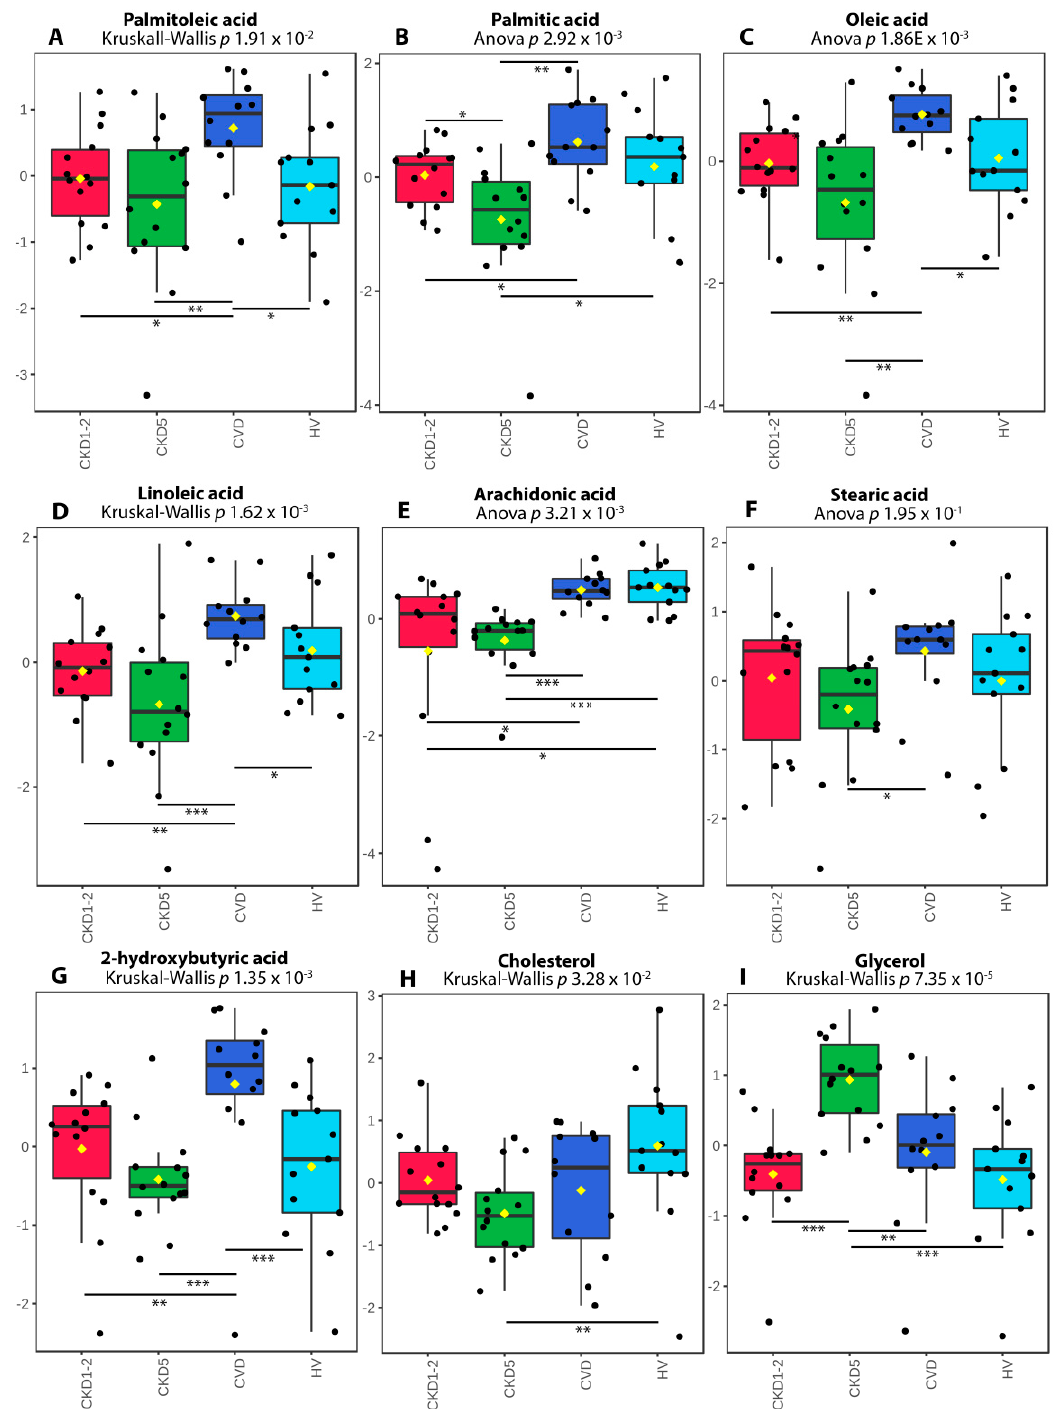
Figure 7. The abundance of differentially accumulated fatty acids, cholesterol and glycerol revealed in GC-MS analysis. ( A ) Palmitoleic acid. ( B ) Palmitic acid. ( C ) Oleic acid. ( D ) Linoleic acid. ( E ) Arachidonic acid. ( F ) Stearic acid. ( G ) 2-hydroxybutyric acid. ( H ) Cholesterol. ( I ) Glycerol. A box on plot presents interquartile ranges and medians. The black dots represent the normalized accumulation of molecules in all samples. The notch indicates the 95% confidence interval around the median of each group. The mean level is indicated with a yellow diamond. Bars and asterisks show results of U-Mann–Whitney/ t -test: * p < 0.05, ** p < 0.01, *** p < 0.001; n = 14 in each group.